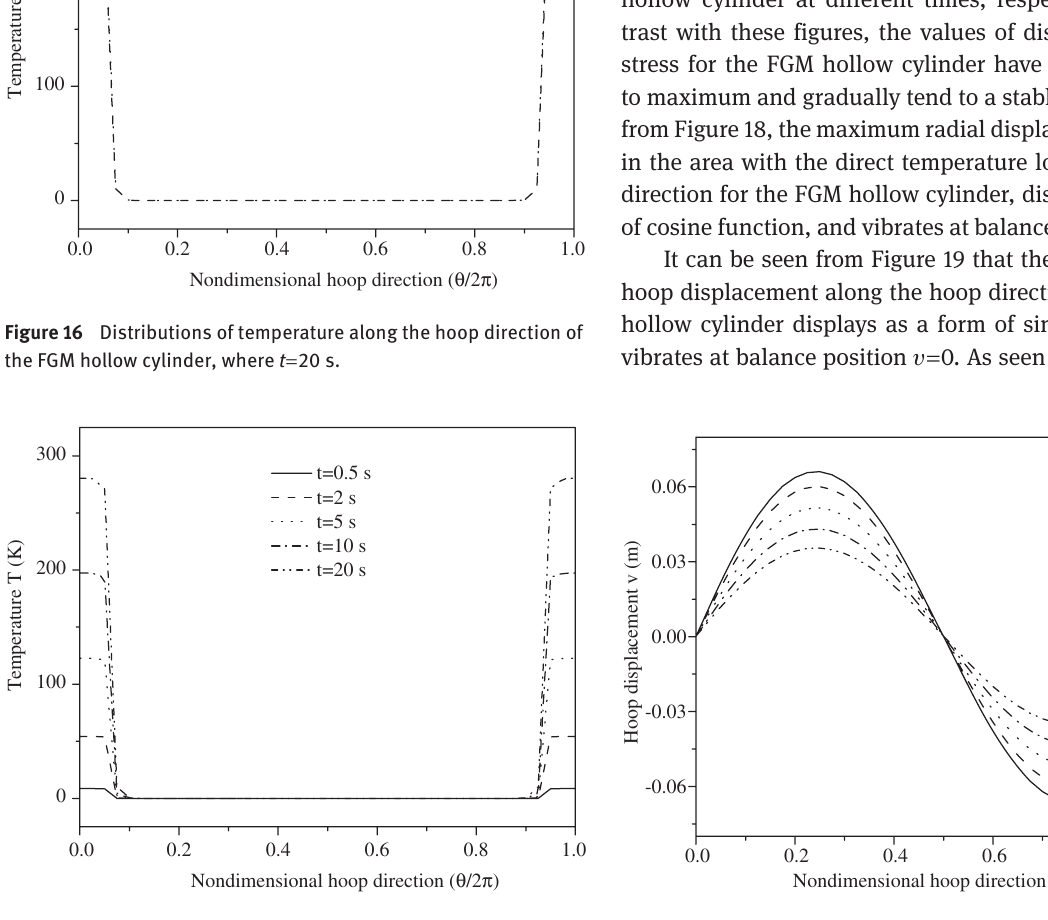
Figure 19 Distributions of hoop displacement along the hoop direc- tion of the FGM hollow cylinder at different